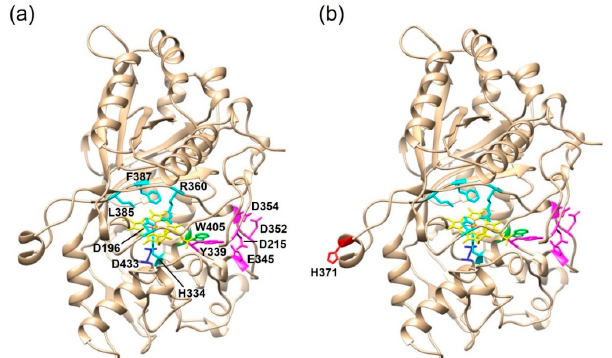
Figure 2. Structural models of PsaPOX variants generated with SWISS ‐ MODEL using the X ‐ ray structure of Pleos ‐ DyP4 (PDB ‐ ID 6FSK). ( a ) Overall fold of PsaPOX_DK showing the typical ferredoxin ‐ like fold, with the heme cofactor in yellow and the heme iron in orange. Conserved amino acids of the active site/hydrogen peroxide pocket (proximal H334, distal D196, R360, L385 and F387) are shown in cyan. D433, which forms a hydrogen bond with H334 to stabilise compound I (oxidised heme after transfer of two electrons to H 2 O 2 ), is presented in blue, and the exposed W405 potentially involved in long ‐ range electron transfer is shown in green. Important amino acids for Mn 2+ ‐ oxidation (D215, Y339, E345, D352 and D354) are highlighted in magenta. ( b ) PsaPOX_high with a single ‐ point mutant (S371H) in comparison to PsaPOX_DK and a ca. 1.5 ‐ fold increased activity. Reprinted from [35].